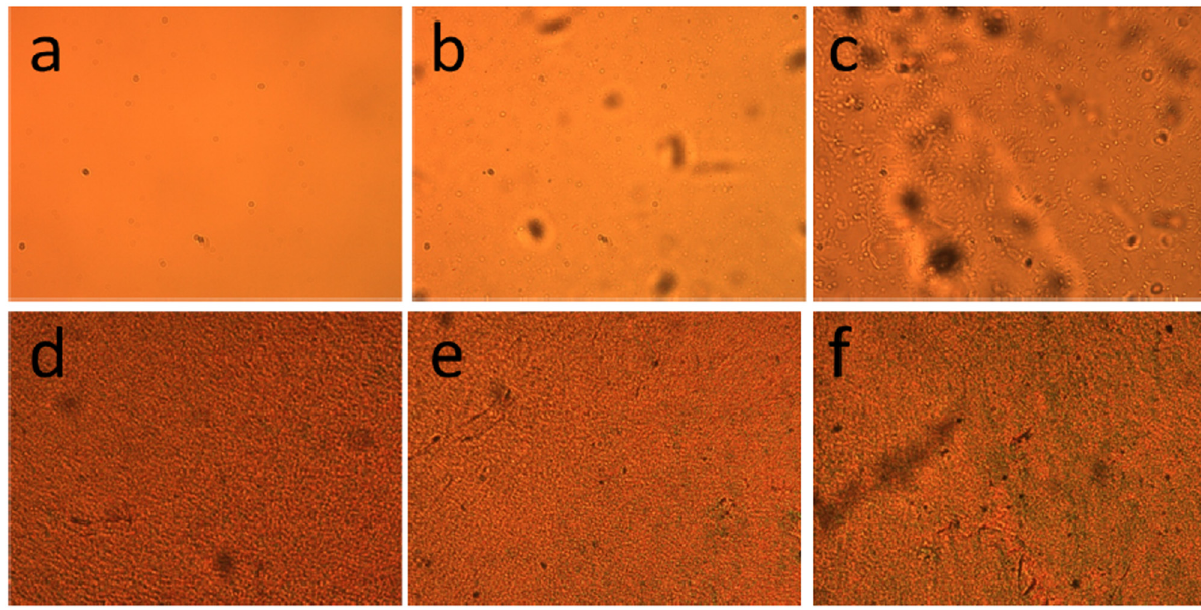
Figure A1: POM photos of PEF - T - 30: ( a ) PEF, ( b ) PEF - 110 - 30, ( c ) PEF - 130 - 30, ( d ) PEF - 150 - 30, ( e ) PEF - 170 - 30, and ( f ) PEF - 190 - 30.